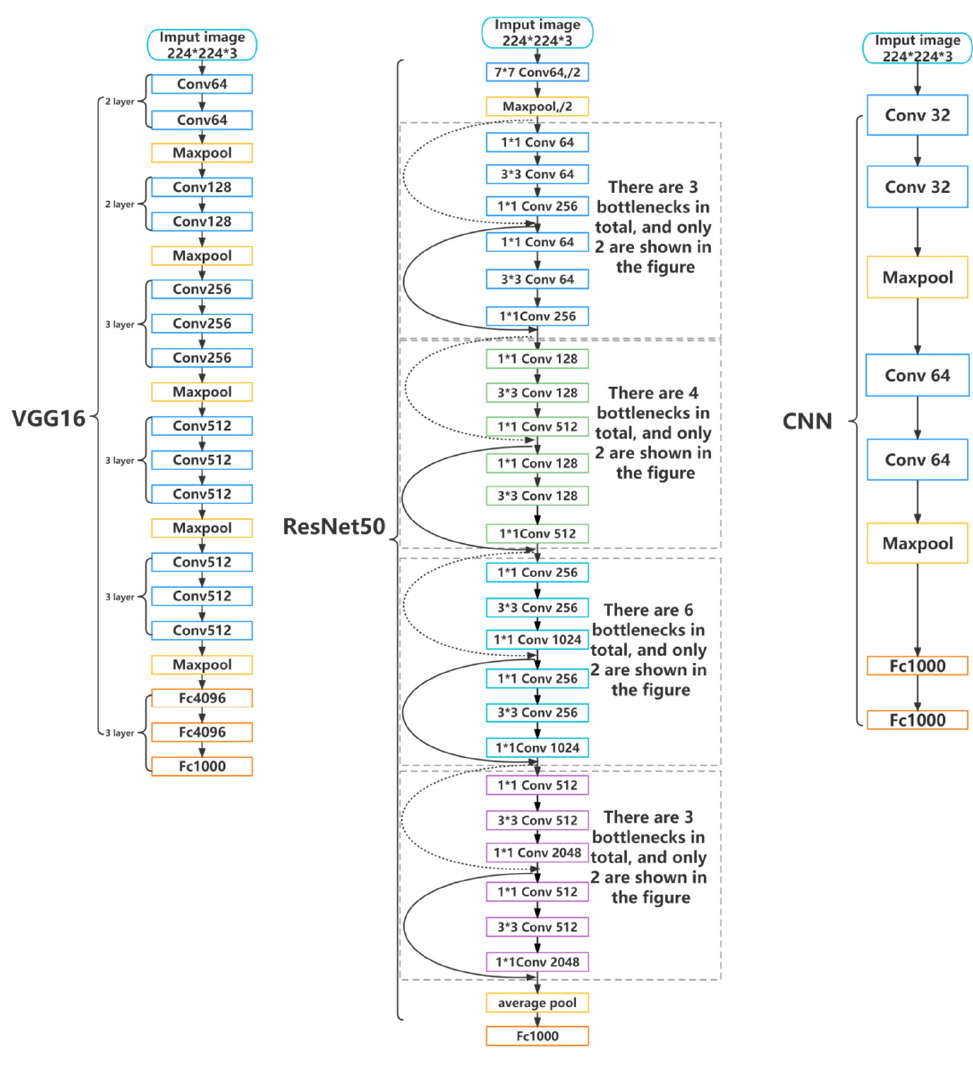
Figure 11. Comparison of three network structures.